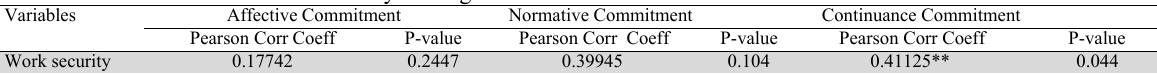
Pearson correlation between work security and organizational commitment Variables Affective Commitment